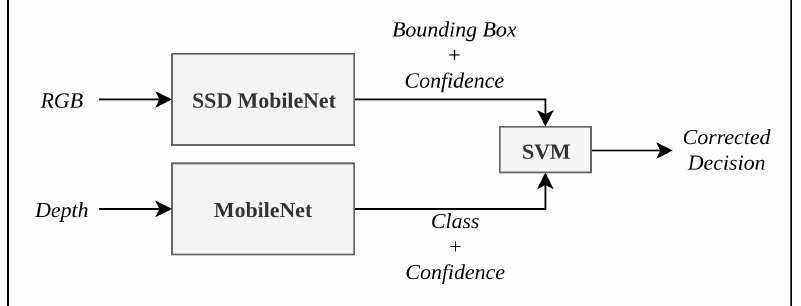
Figure 7. False detection correction using